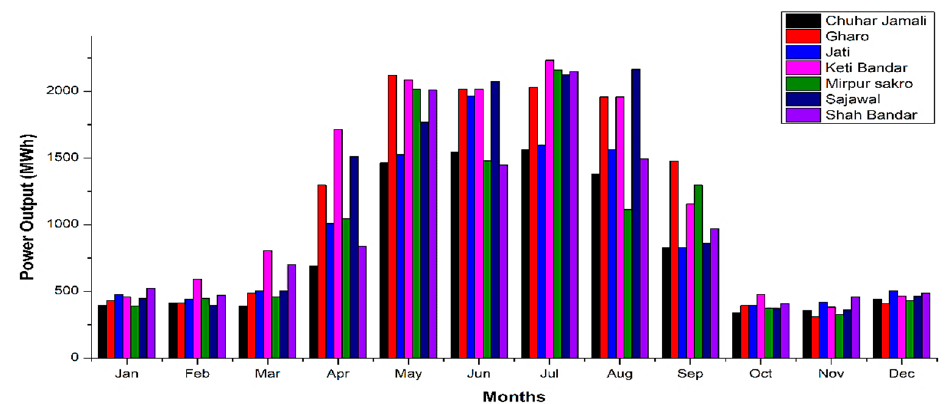
Figure 11 . Annual Wind Speed for Zone 2 (Thatta).